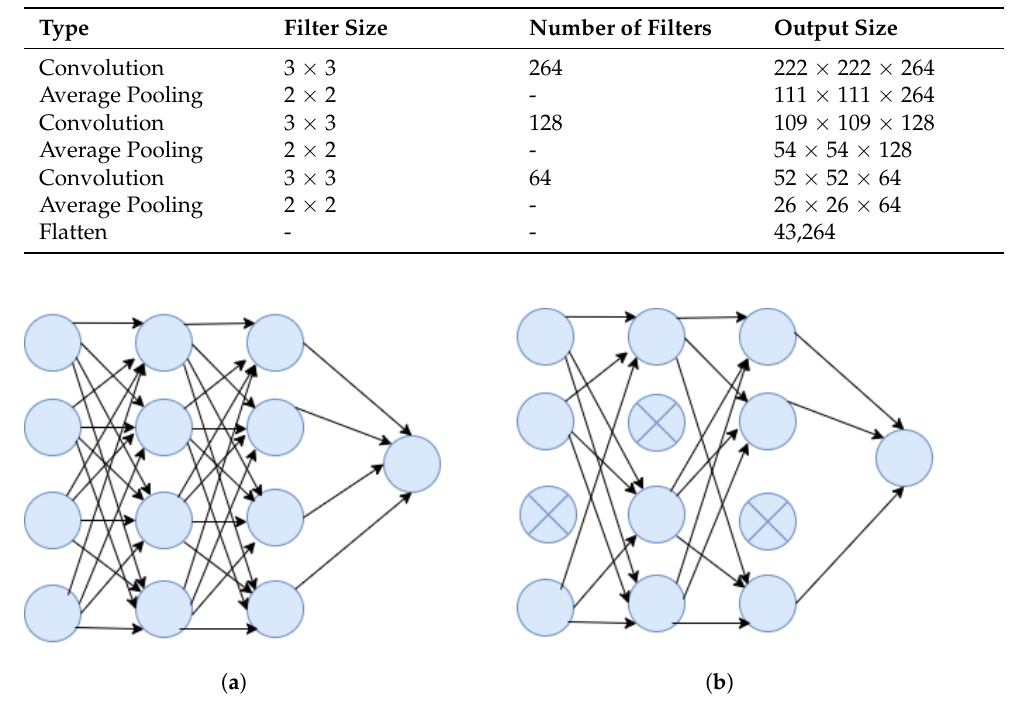
Table 2. CNN for feature extraction from input images of size 224 × 224 × 3.